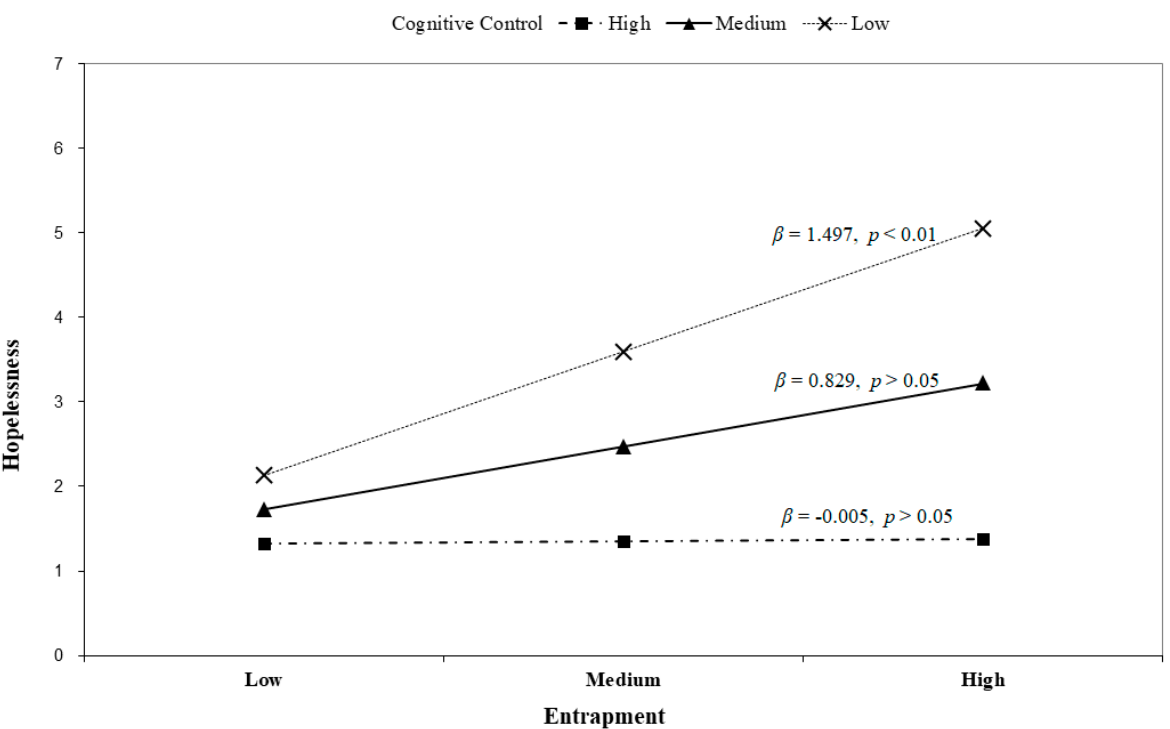
Figure 2. Interaction of cognitive control and entrapment on hopelessness.